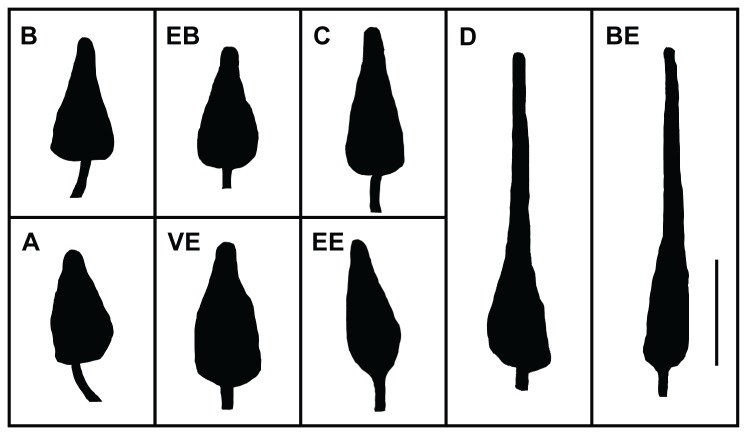
Sperm morphologies of Red Sea, Western Indian Ocean and Indo-West Pacific Echinometra.